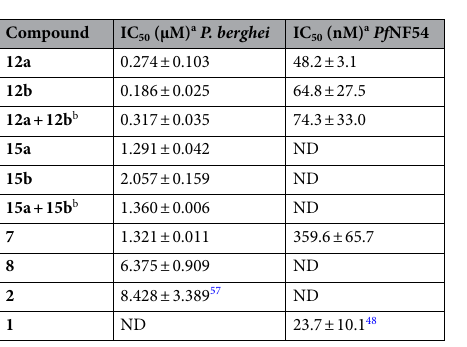
Table 1. IC 50 values of selected compounds against the hepatic stage of P. berghei and the erythrocytic stage of P. falciparum NF54 infections. a Results are represented as mean ± SD, n ≥ 2. ND: not determined. b Original isolated mixture, before